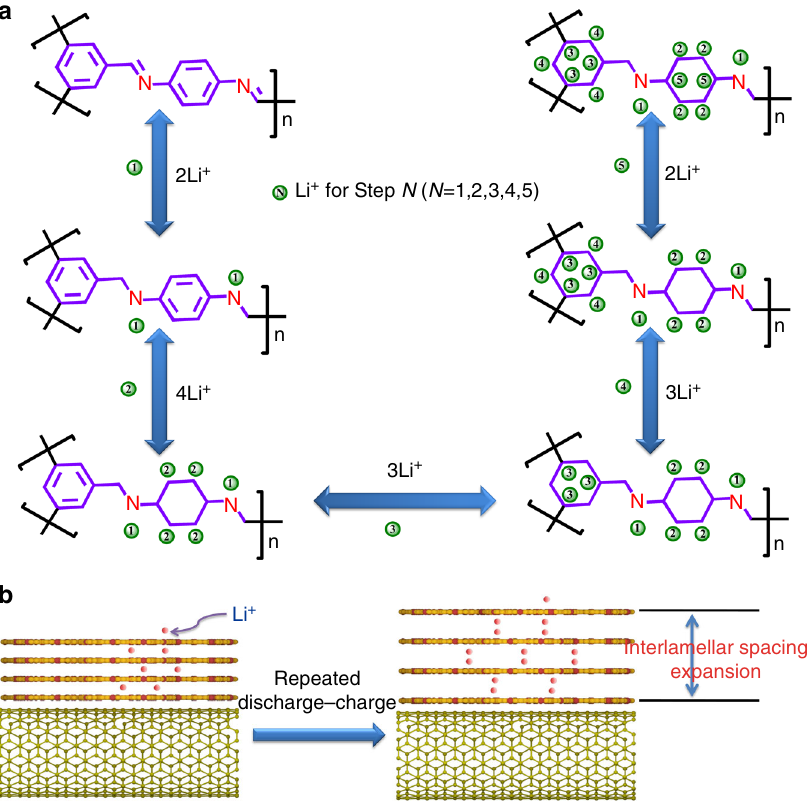
Fig. 8 Schematical illustration showing stepwise lithium-storage mechanism for COF in the COF@CNTs anode. a Reversible fi ve-step lithium-ion insertion and extraction reactions with a COF monomer. b The facilitated lithium-ion transport and storage into expanded COF layers during the repeated lithiation and delithiation